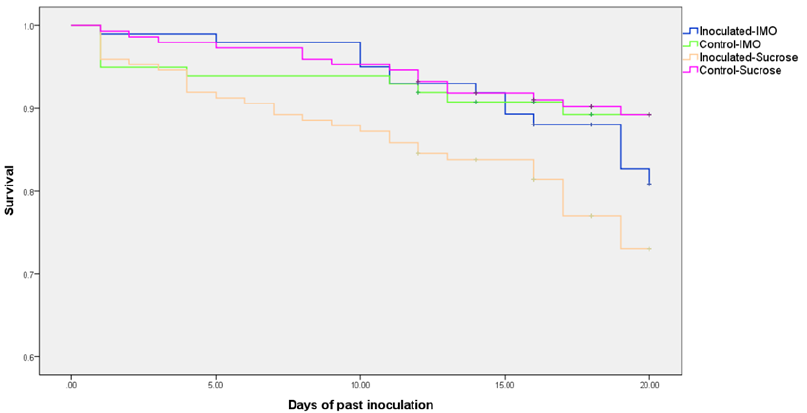
Figure 2. Survival analysis using the Kaplan–Meier method of the four treatment groups. Only the group inoculated with sucrose showed a significant increase in group inoculated with sucrose showed a significant increase in mortality.